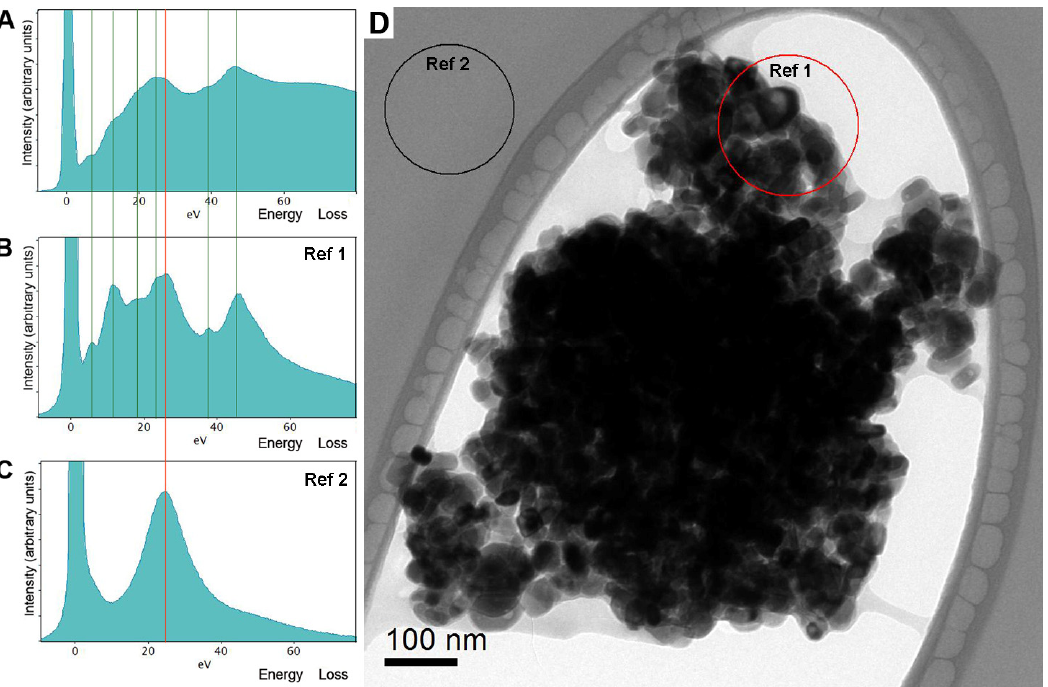
Figure 2. EELS spectra of bulk plasmon energy region obtained from the original macroemulsion ( A ) and titanium dioxide-carbon reference samples ( B , C ); The green lines show correlation between Ti low loss peaks which are present in both: low loss regions of macroemulsion and the reference spectra; red line indicates carbon low loss peak; ( D ) zero-loss filtered bright field TEM images of titanium dioxide-carbon reference sample. Selected areas indicate positions where EELS spectra for Ref. 1 and Ref. 2 were